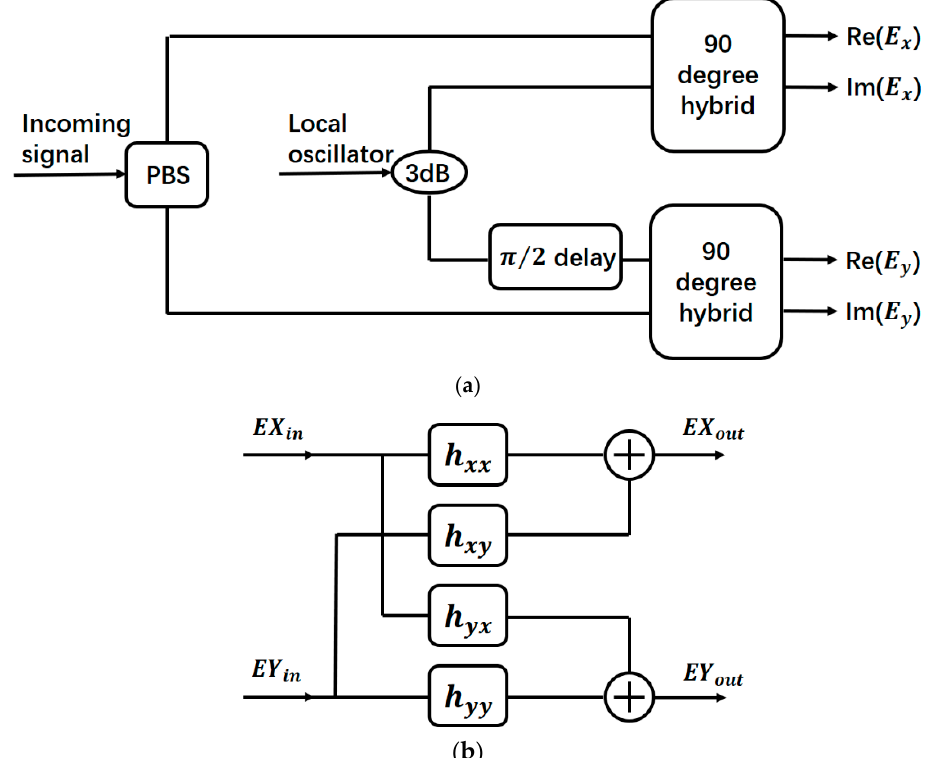
Figure 1. ( a ) Schematic of a typical coherent receiver; ( b ) Equalizer with butterfly